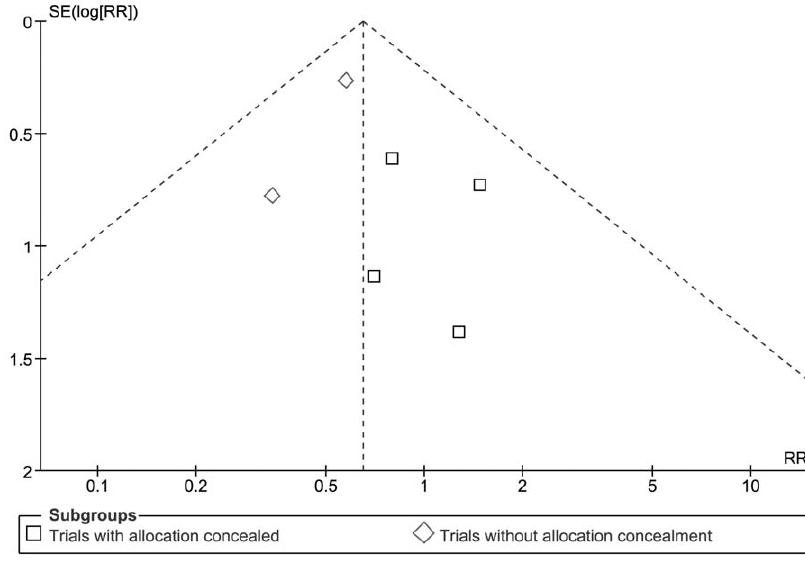
Figure 3. Funnel plot of effect on mortality prior to hospital discharge.